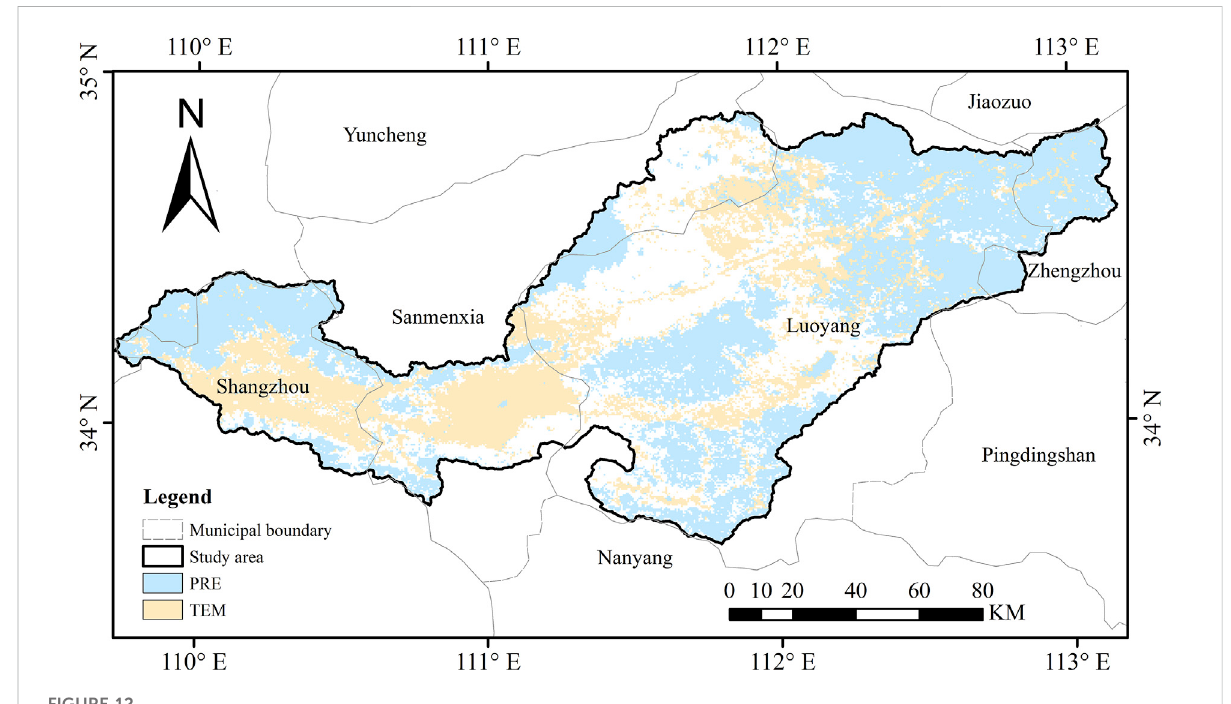
FIGURE 12 Factor that has a greater impact on NPP in each pixel in the